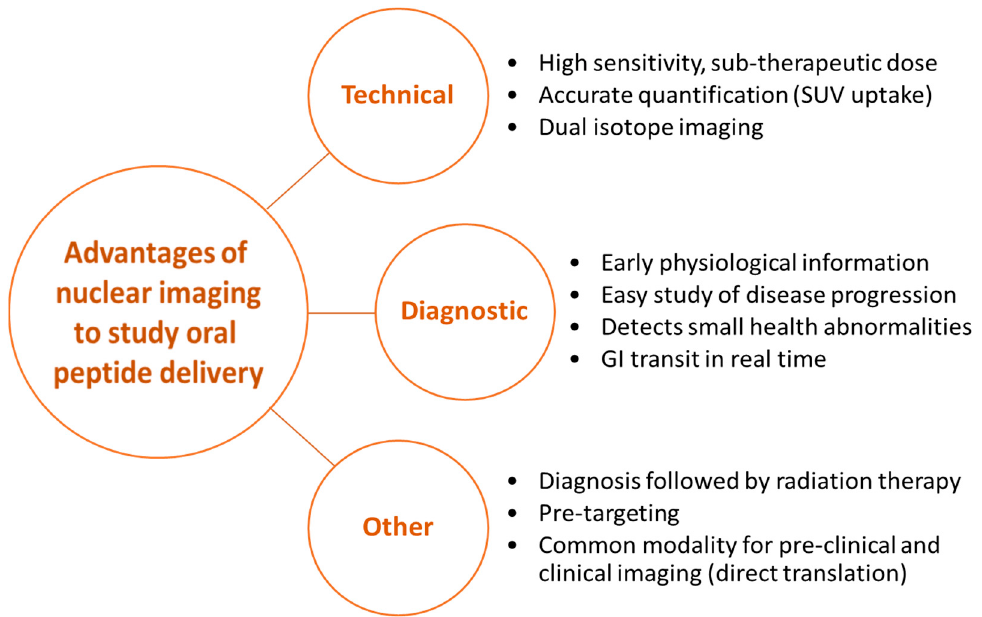
Figure 13. Advantages of nuclear imaging to study oral delivery of